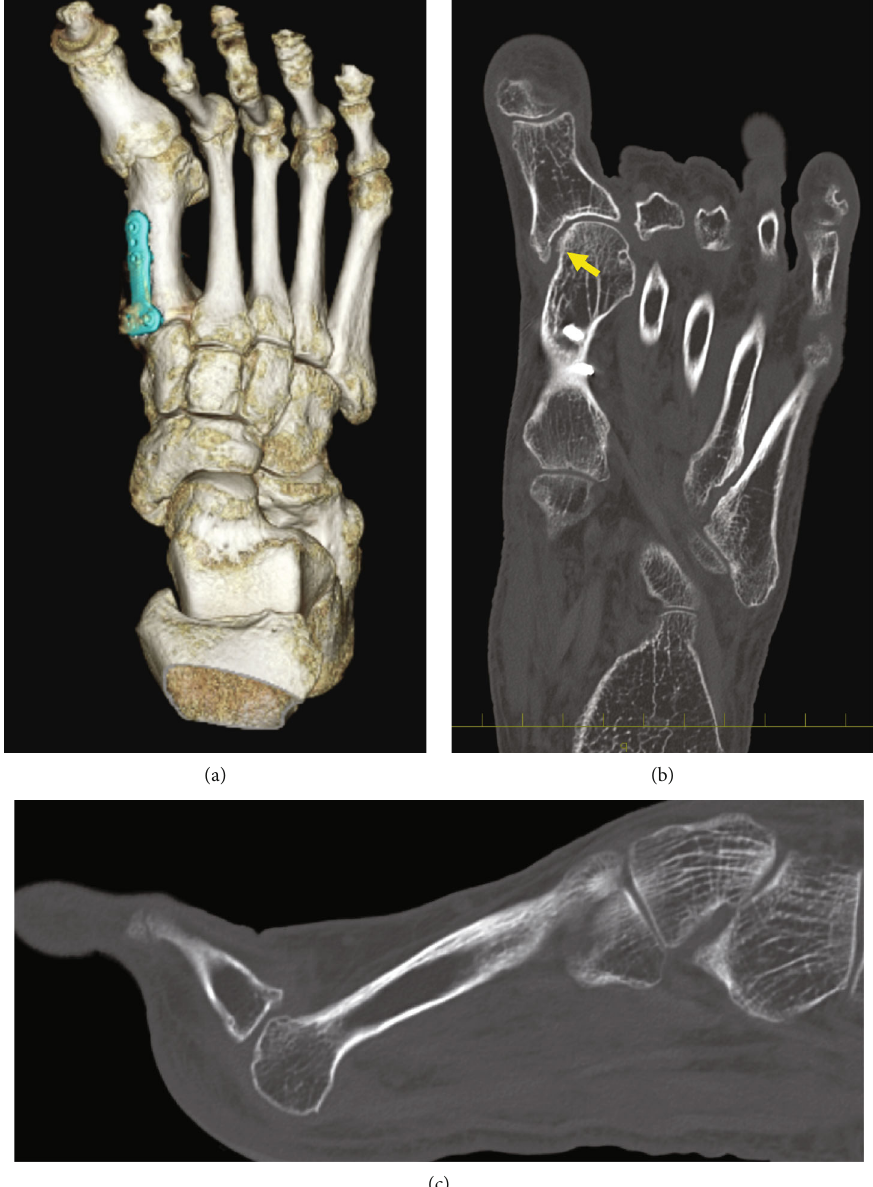
Figure 2: Preoperative CT images. (a) 3DCT image. (b) Coronal image. Arrow indicates decreasing the surface area of the medial side of the articular surface at the fi rst metatarsal head by resection of the bony prominence. (c) Dorsal dislocation of the 2nd toe. CT: computed tomography; 3DCT: three-dimensional computed